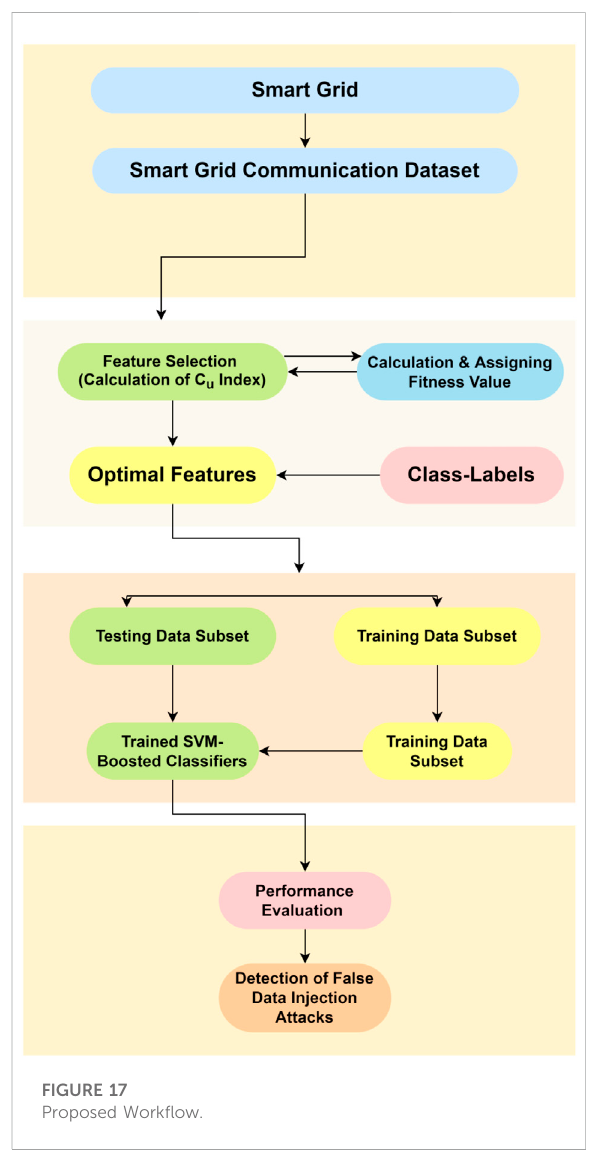
FIGURE 17 Proposed Work fl